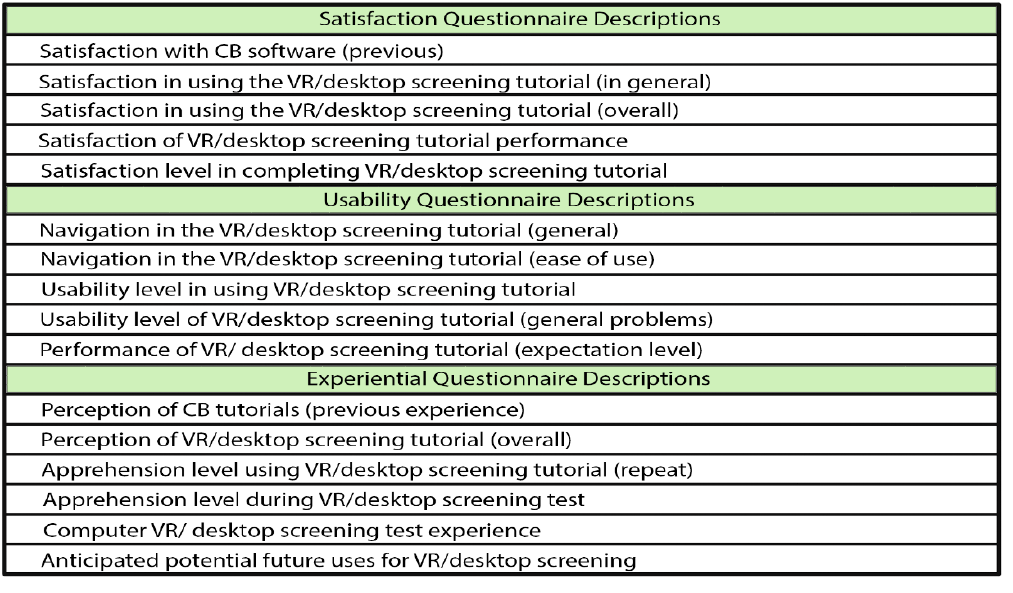
Figure 7. Grouped satisfaction questionnaire.